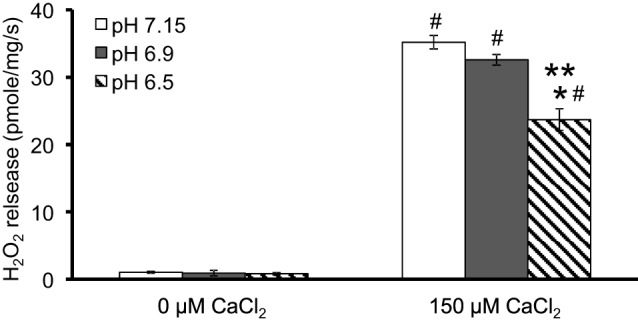
Summary of the effects of pH and added CaCl2 on rates of H2O2 release rate in succinate-energized mitochondria after inhibiting complex III with AA. Columns represent mean values ± SEM of pmol H2O2 generated/mg/s. P < 0.05 *Significant difference in H2O2 release rate at pH 6.9 or pH 6.5 vs. pH 7.15 within the same CaCl2 group. **Significant difference in H2O2 release rate at pH 6.5 vs. pH 6.9 within the same CaCl2 group. #Significant difference in H2O2 release rate in 150 μM CaCl2 vs. 0 μM CaCl2 for each pH group. N = 4 each.